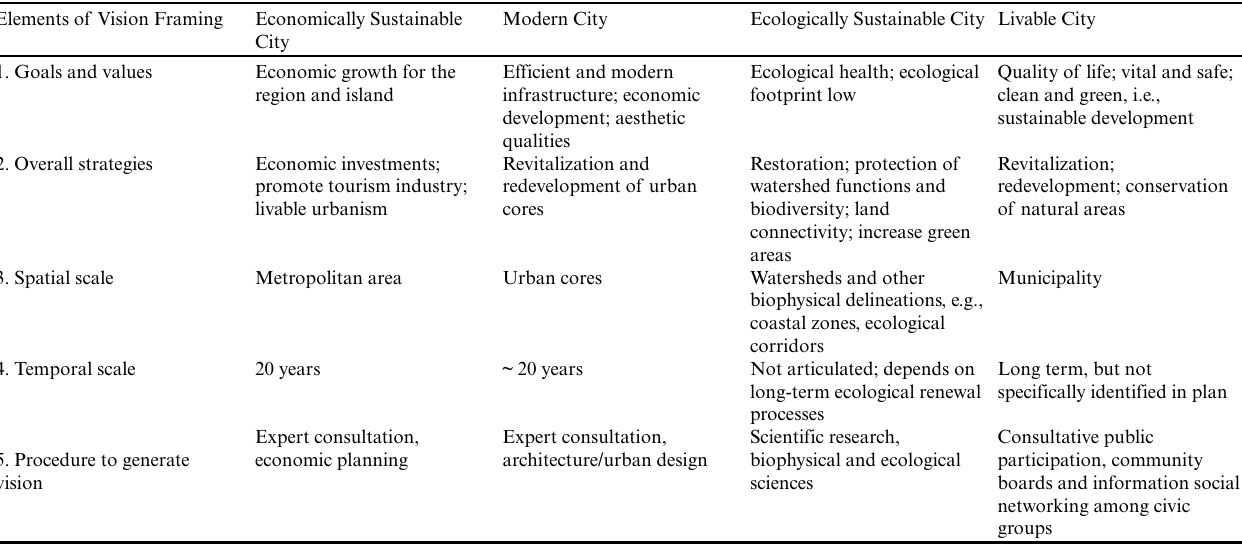
Table 1 . Summary of the characteristics of each vision for the future of San